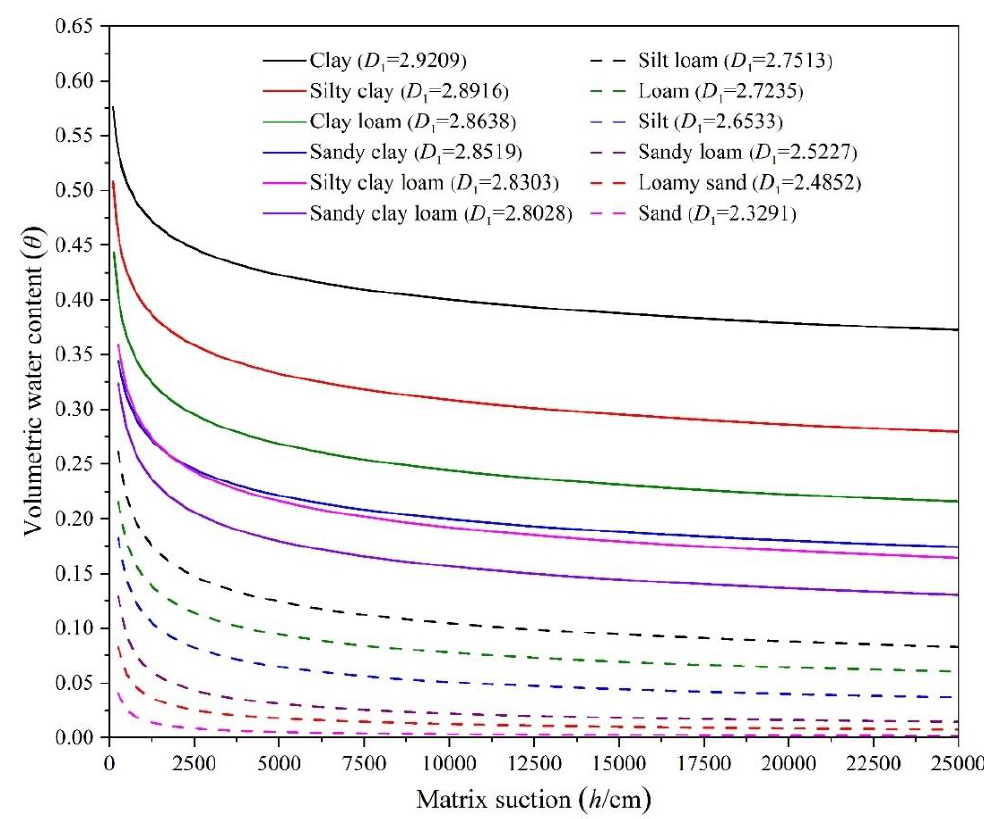
Figure 2. Soil-water characteristic curves (SWCCs) of 12 soil textures predicted using the SWCC fractal model. fractal